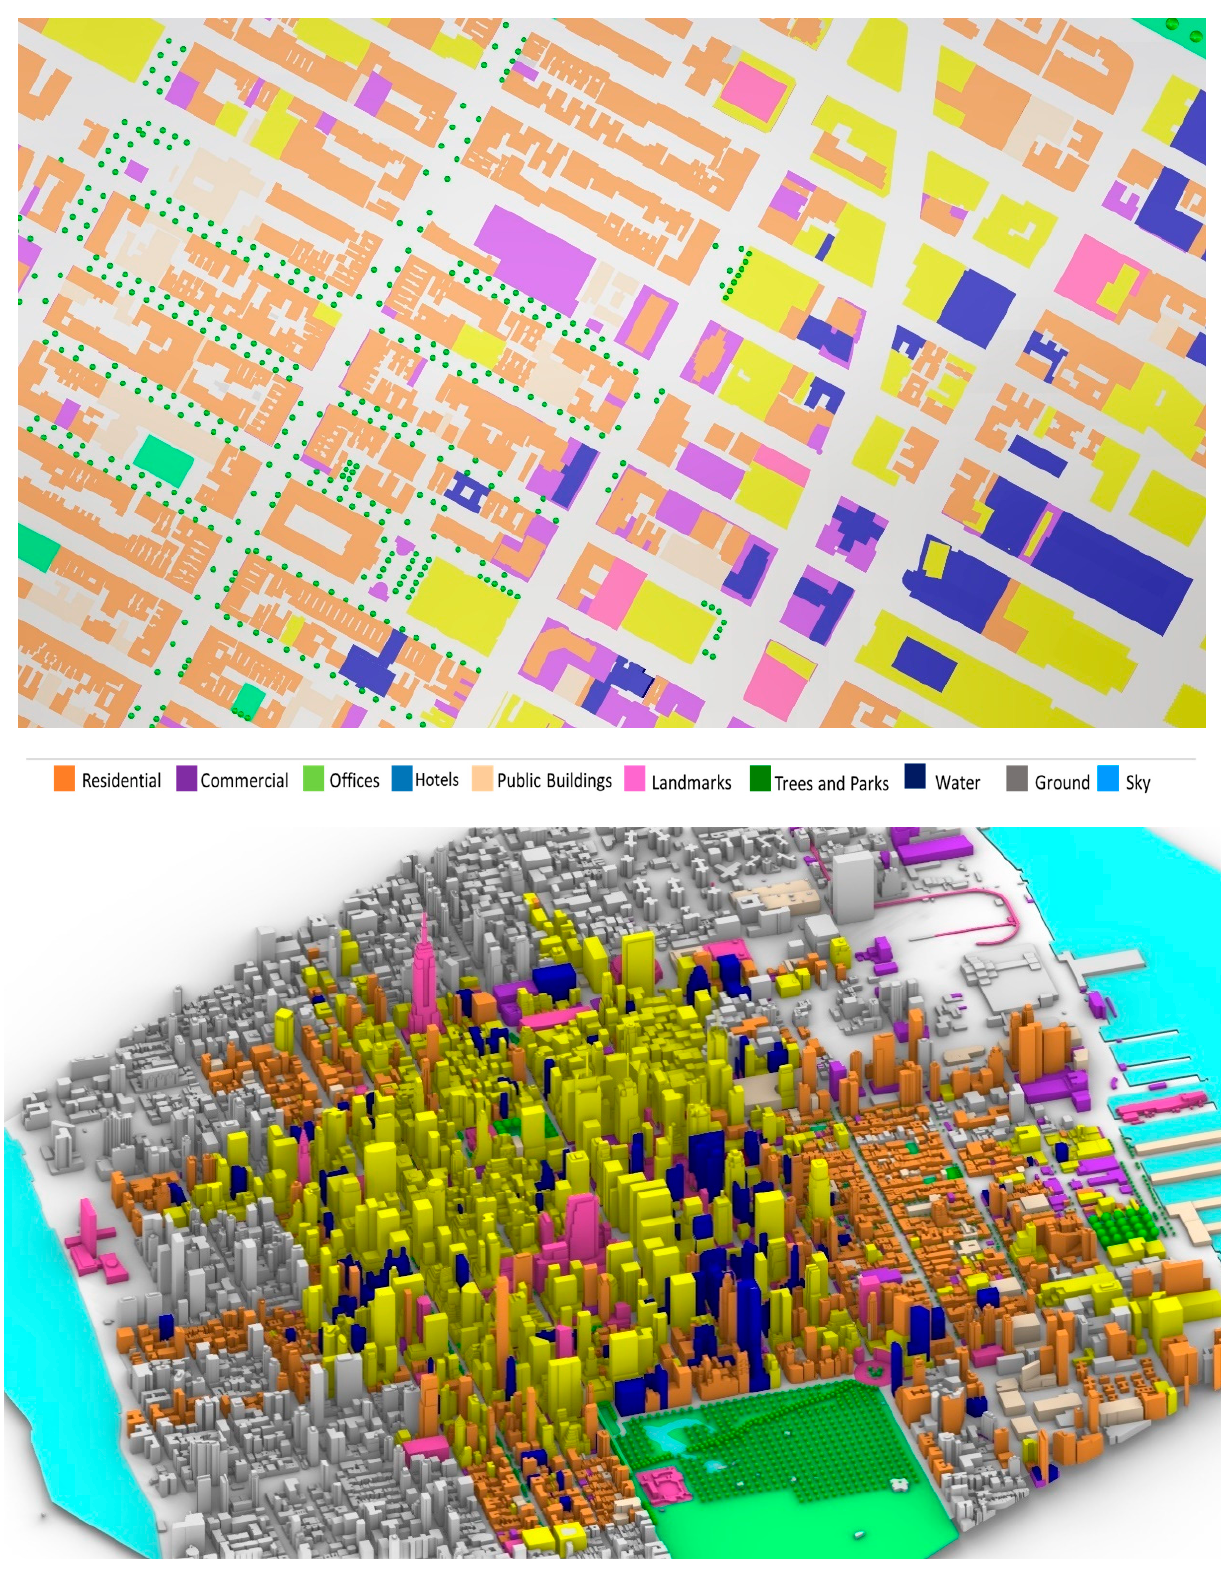
Figure 4. Colored features of different element categories in Manhattan, NYC ( top ), and the Rhino 3D model of the same area depicting the urban fabric colored according to the different element categories ( bottom ).